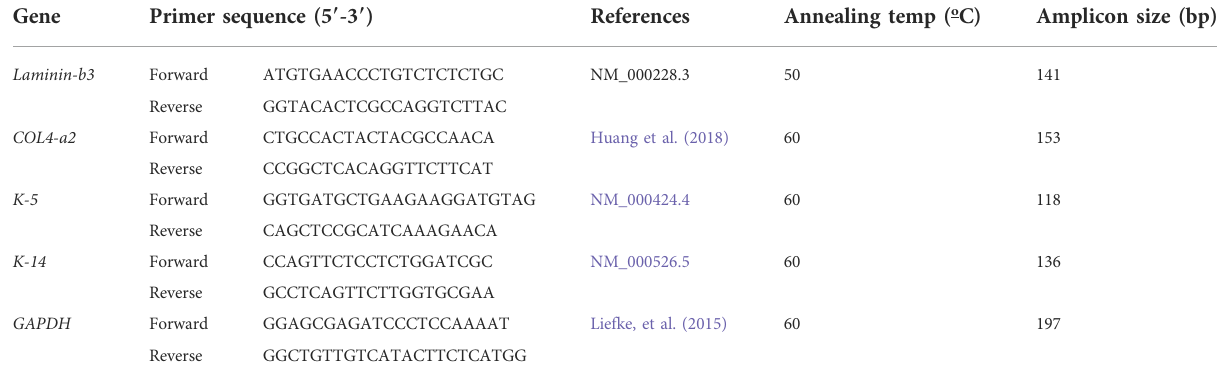
TABLE 1 Real time PCR